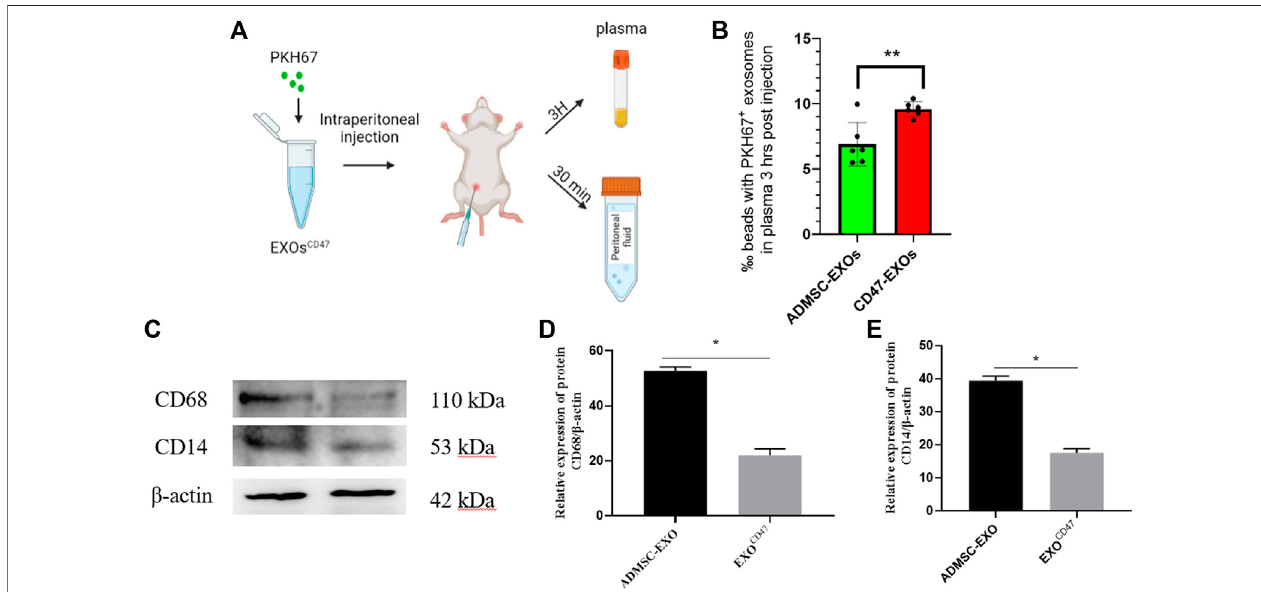
FIGURE 3 | (A) Experimental procedure used to examine the in vivo stability of EXOs. (B) Retention of EXOs at 3 h after intraperitoneal injection of ADMSC-EXOs (control) and EXOs CD47 . n = 6, ** p < 0.01. (C – E) Western blotting of lavage fl uid for CD68 and CD14 (macrophage markers) in the ADMSC-EXOs (control) and EXOs CD47 groups. N = 3, * p <